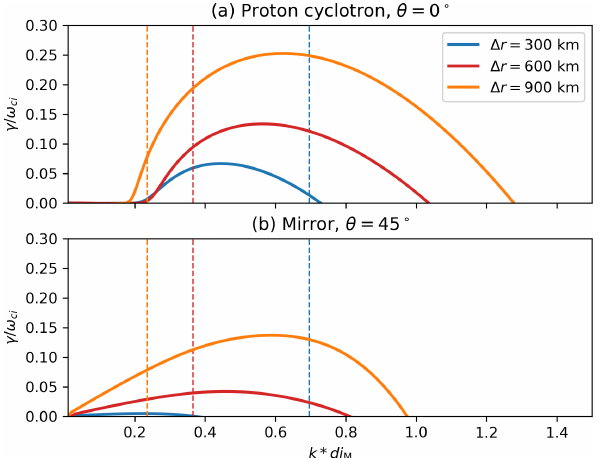
Figure 6. Growth rates, γ , of the proton cyclotron (a) and mir- ror (b) instabilities calculated by HYDROS for the three different spatial resolutions: (cid:49)r = 300km (blue), (cid:49)r = 600km (red) and (cid:49)r = 900km (orange). The dashed lines represent the maximum wave number, k max = π/ 2 (cid:49)r , which can be resolved by the model to get a proper description of the signal at each resolution.